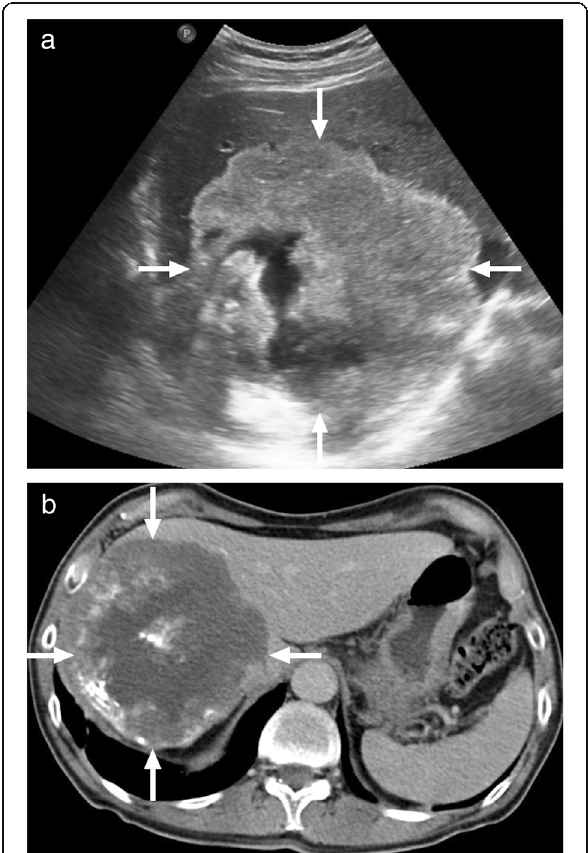
Fig. 5 A 65-year-old male recently presented with right upper quadrant pain and abnormal liver function tests. a Abdominal ultrasound demonstrates lobulated, centrally cystic mass (arrows) within the right liver lobe. The mass was mostly hyperechoic in echotexture. b Axial plane postcontrast CT demonstrated a large, hypoattenuating, centrally cystic/necrotic liver mass (arrows) with scattered calcifications. Percutaneous biopsy was performed to exclude cholangiocellular cancer. Final diagnosis was alveolar hydatid cyst. The patient underwent right